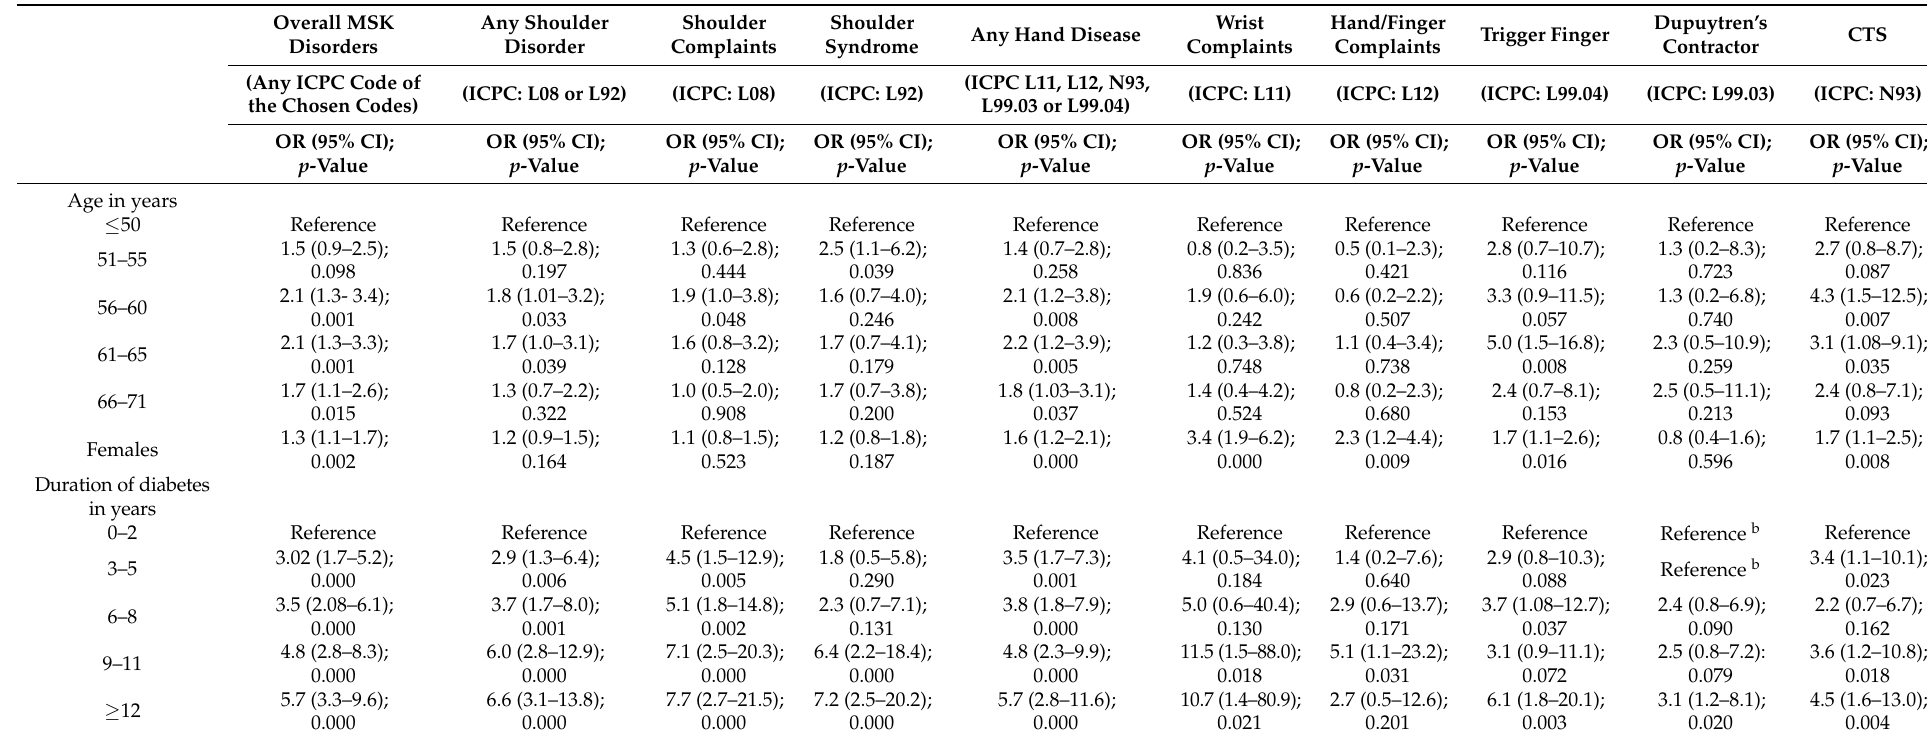
Table 3. Regression analysis of specific upper extremity musculoskeletal disorders in patients with type 2 diabetes in RNFM approach a